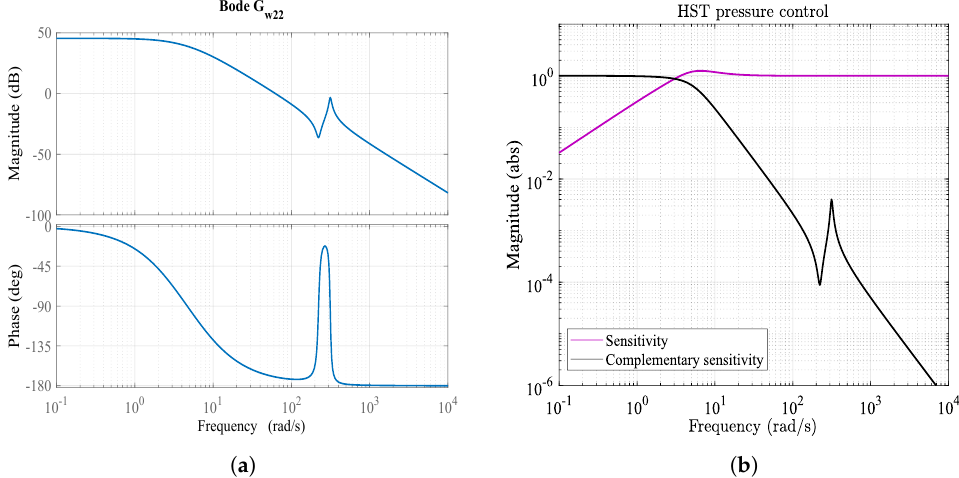
Figure 8. Open-loop and closed-loop frequency responses of the HST pressure. ( a ) Frequency response of G w22 ( s ) . ( b ) Closed-loop response of the plant G w22 ( s ) . A PI controller, C 2 ( s ) (= − 0.0058 − 0.0165 s